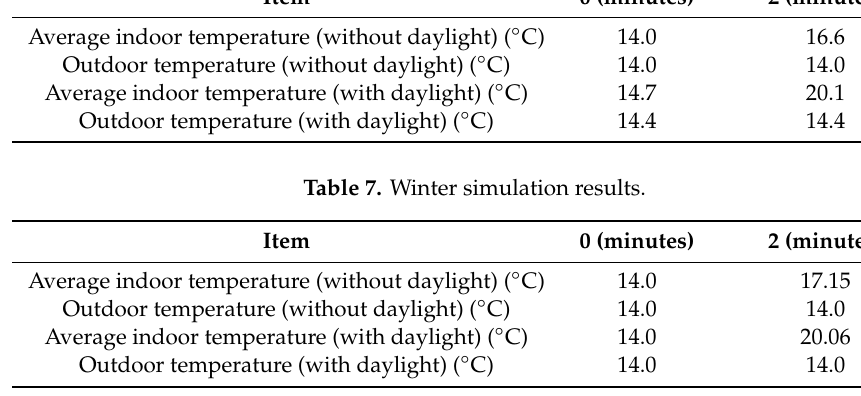
Table 7. Winter simulation results.